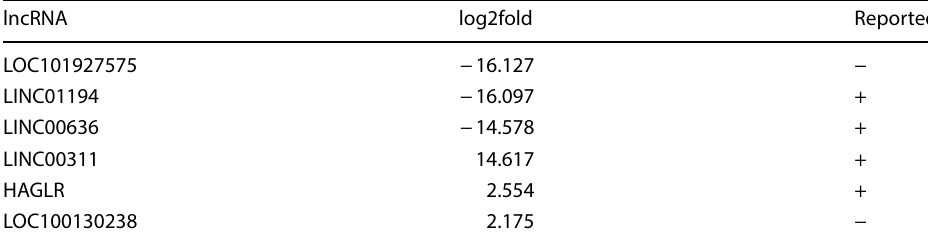
specified transcripts are not indicated in any